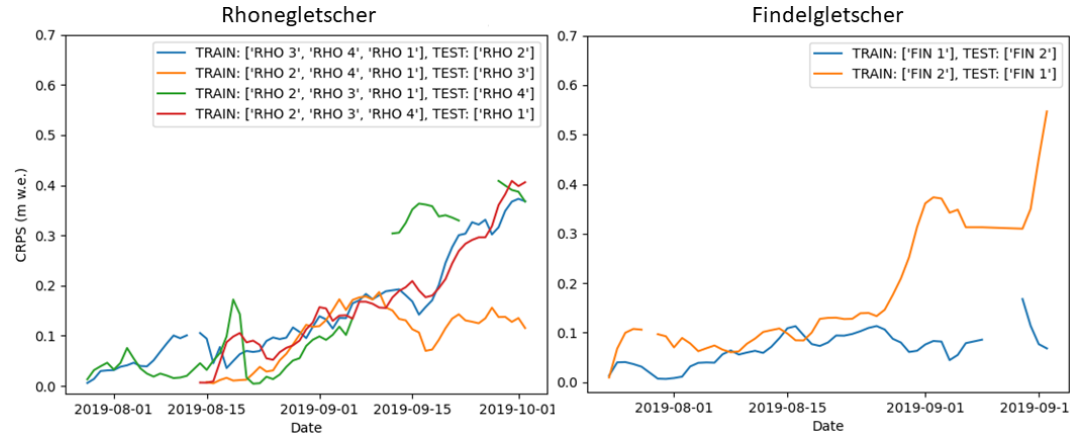
Figure 9. Temporal evolution of the CRPS as determined in a leave-one-out cross-validation procedure on Rhonegletscher and Findel- gletscher. “TRAIN” and “TEST” stand for the stations assimilated by the particle filter and the station used for the validation, respectively.